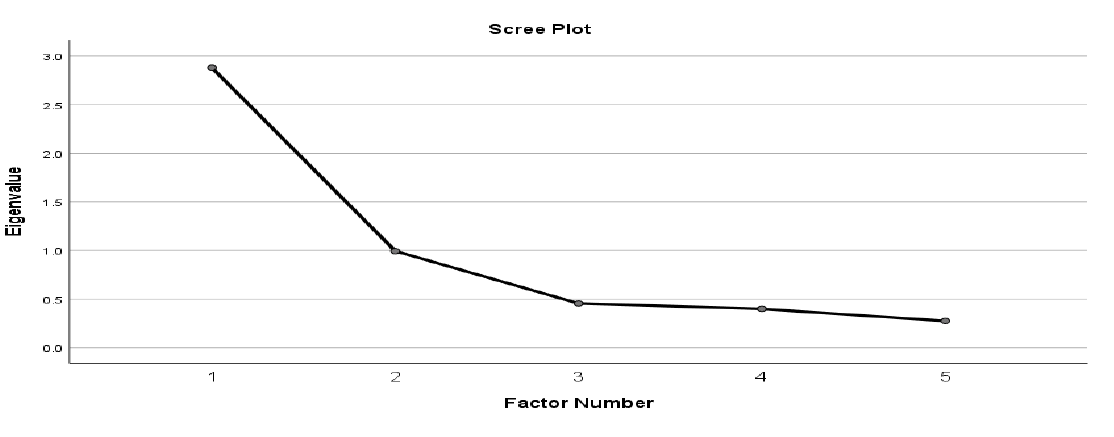
Figure 1. The Scree Plot.